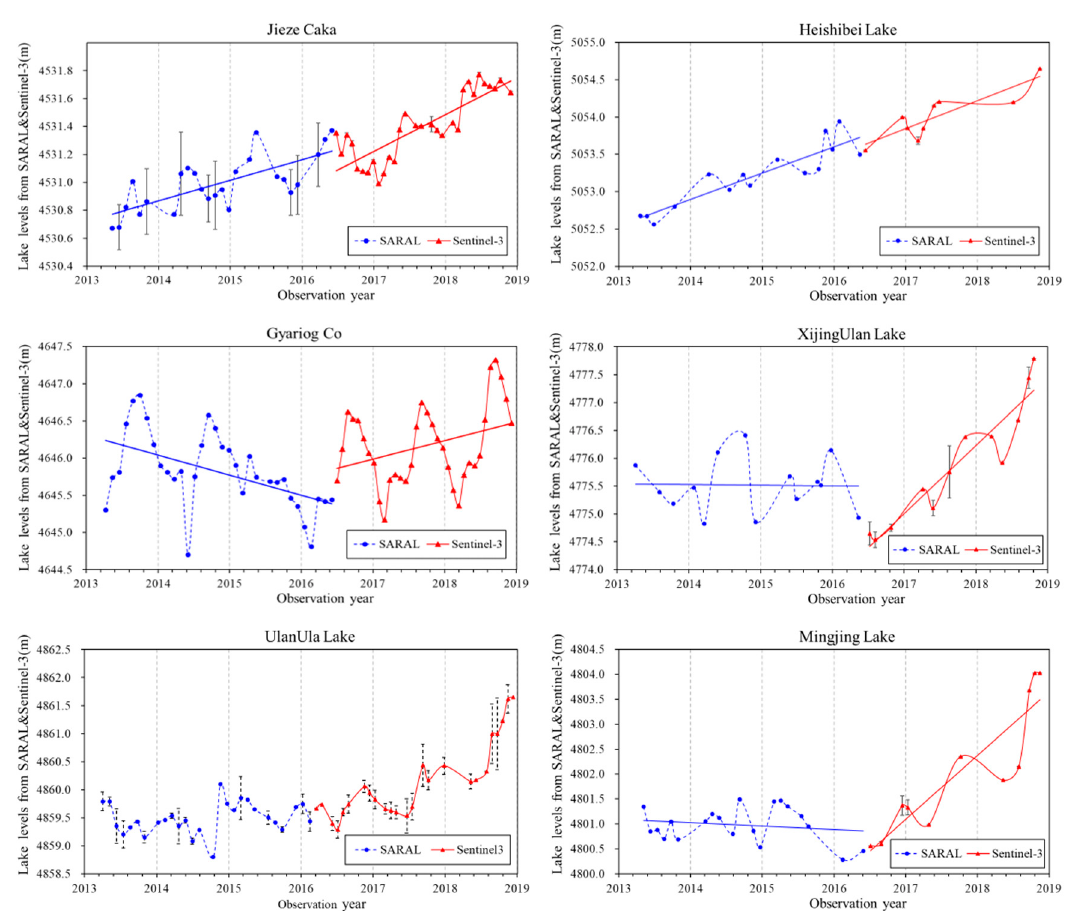
Figure6. Lakelevelchangesduringtheperiod2013–2018basedonSARALandSentinel-3altimetrydata. Figure 6. Lake level changes during the period 2013–2018 based on SARAL and Sentinel-3 altimetry Remote Sens. 2020 , 12 , x FOR PEER REVIEW data.